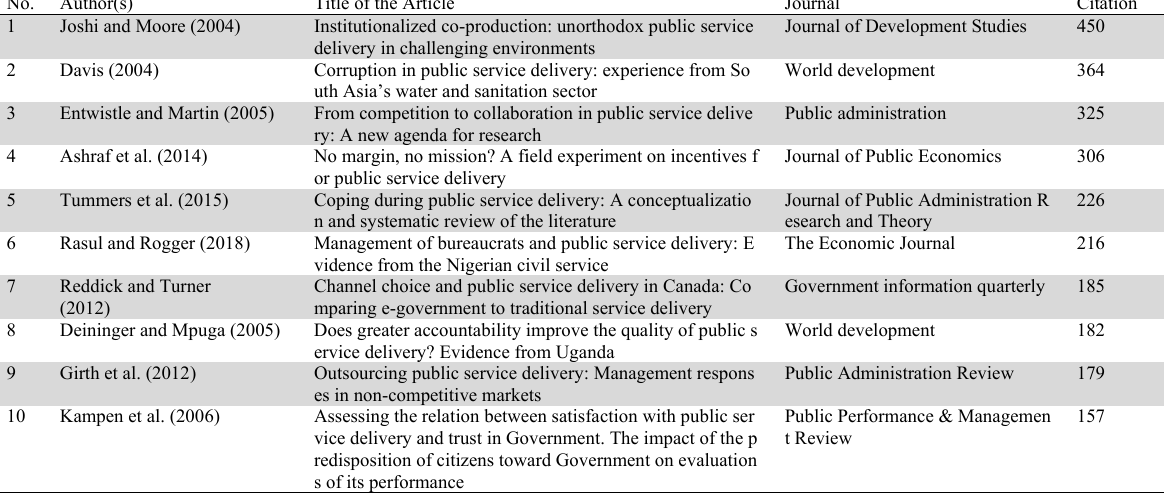
Most frequently cited articles on the concept of public service delivery over the last twenty-three years (between 1996 to 2019) and according to the citation